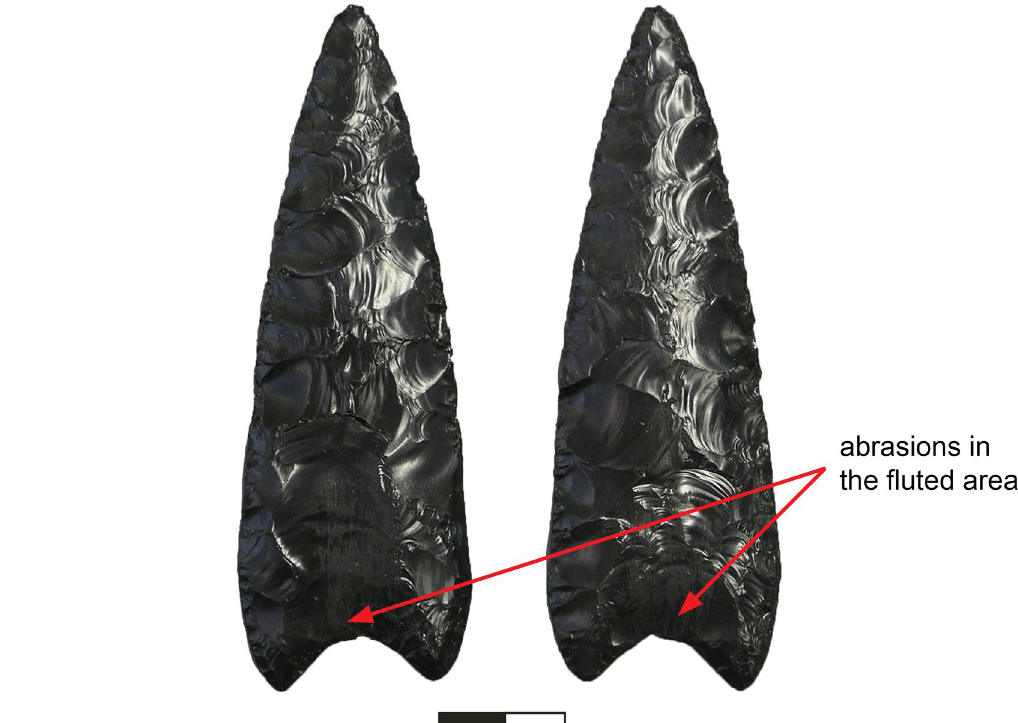
Figure 3. Clovis fluted point from the Fenn cache that has pronounced scratches in the fluted areas on both faces, and may display evidence of an amber mastic (image after Slade 2016). The scale bar is 2cm wide (in 1 cm segments).